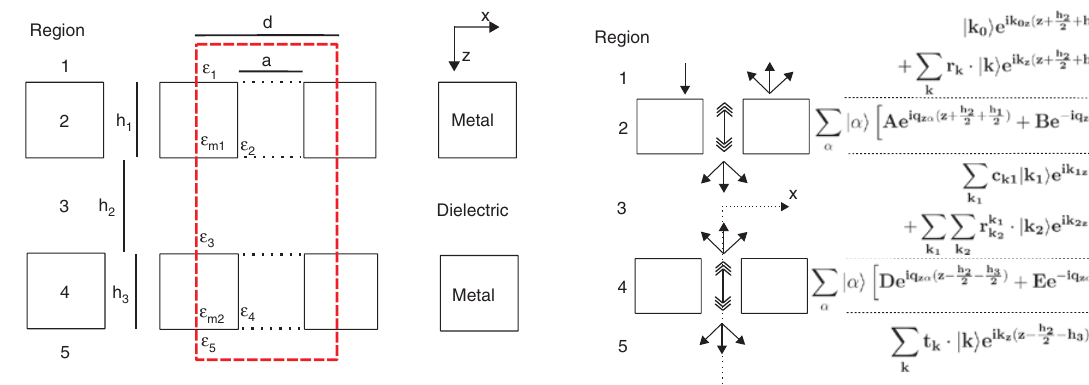
, h , and h for the top metal, 1 2 3